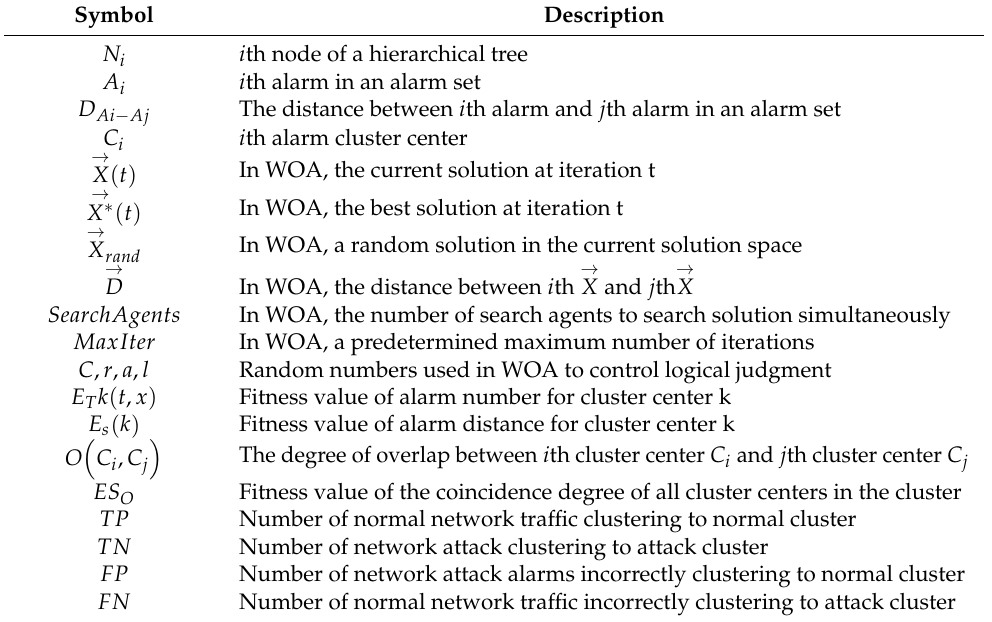
Table 1. Table of notations used in this